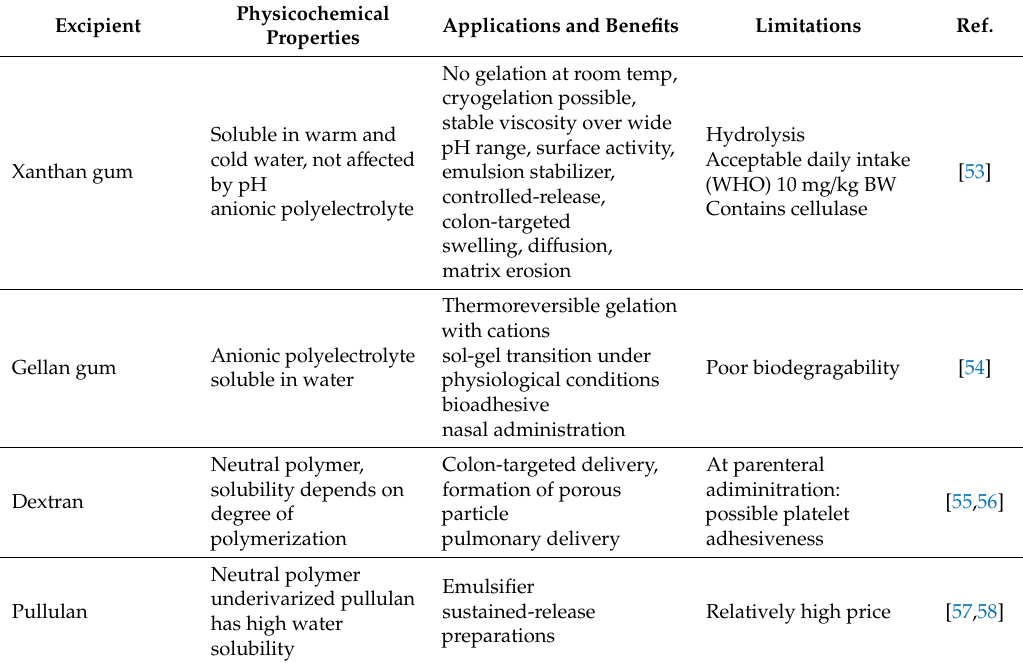
Table 3. Examples of polysaccharides of microbial fermentation used in microencapsulation. Excipient